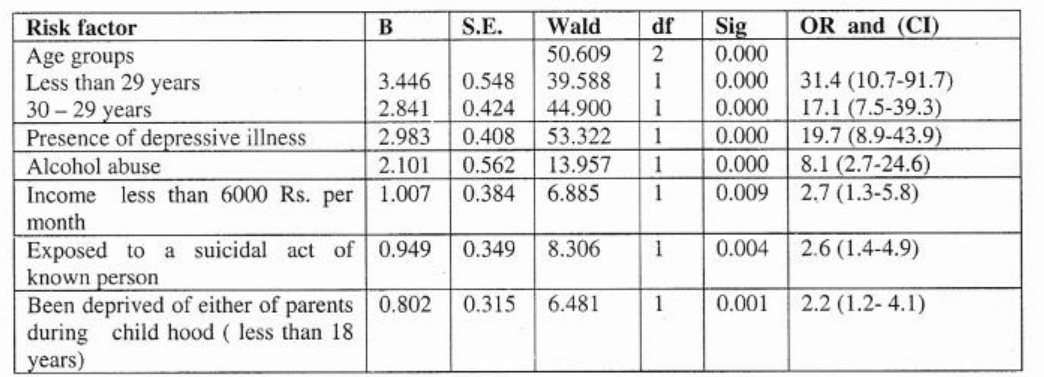
Table 4 : Results oflogistic regression